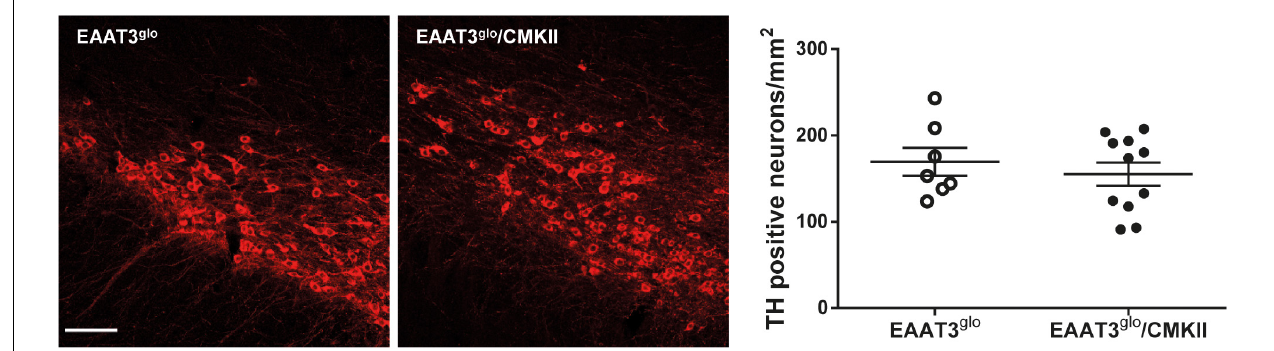
FIGURE 4 | The number of DA neurons is preserved in EAAT3 glo /CMKII mice. Immunohistochemistry was made against tyrosine hydroxylase (TH) in 30- µ m-thick coronal sections spanning the rostrocaudal axis containing the substantia nigra pars compacta (SNc); the number of TH-positive neurons was quantified and standardized by area in mm 2 . Images depict 10 × representative maximum intensity projections of flattened z-stack pictures. Scale bar: 50 µ m. EAAT3 glo n = 7 (3M, 4F); EAAT3 glo /CMKII n = 11 (8M, 3F).